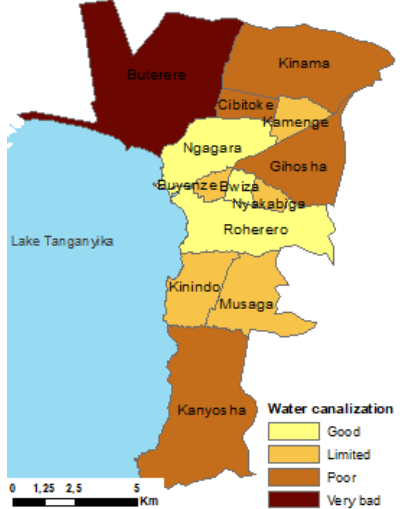
Figure 6. Distance to channels : more than 50 buildings were located in the 20 meters distance to rivers in the North of the city